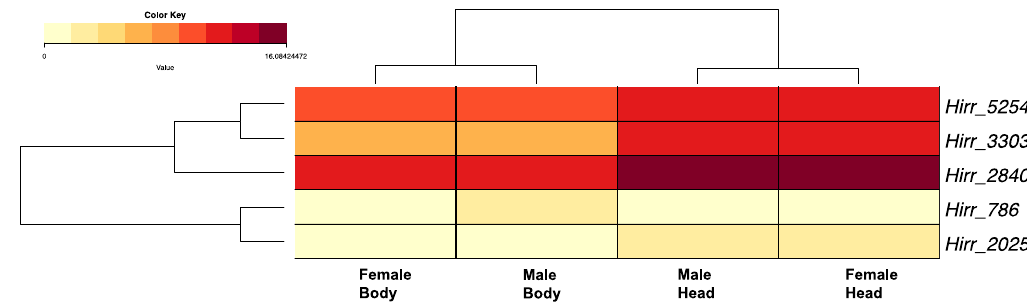
Figure 5. Heat map and hierarchical clustering dendrogram of Haematobia irritans candidate chemosensory protein (CSP) transcripts in female and male head appendages (Head) and headless bodies (Body). Log-transformed TPM values were used to construct the heat map. Dendrogram reflects transcripts with similar expression patterns, identified by hierarchical clustering applied to expression values (rows) and dataset categories